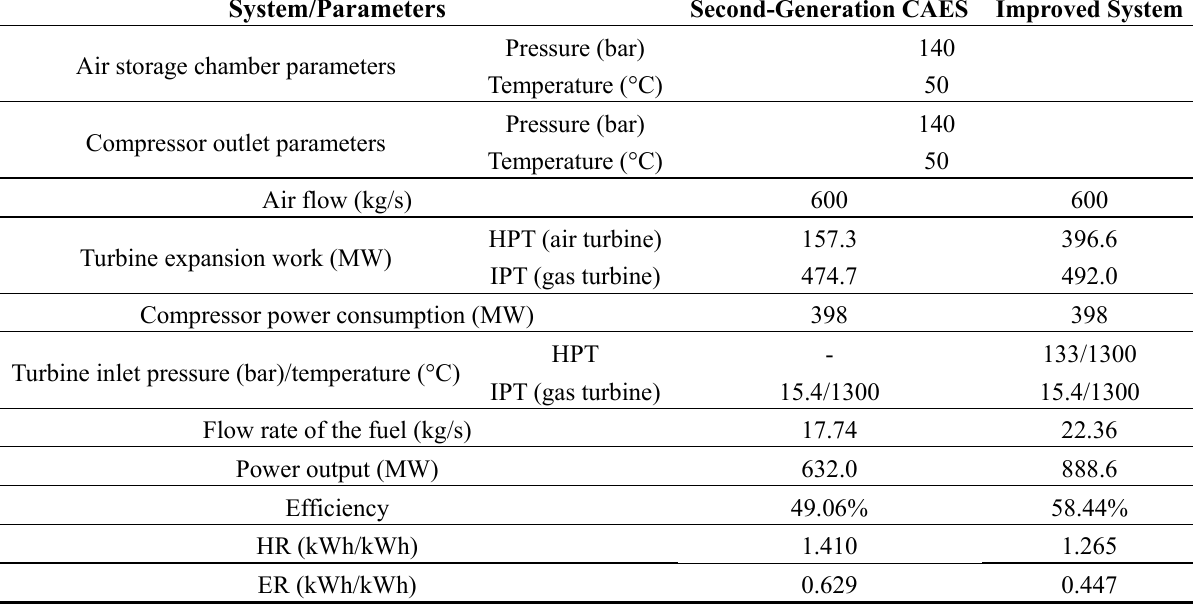
Table 2. Comparison of the parameters of second-generation CAES systems with those of the improved CAES